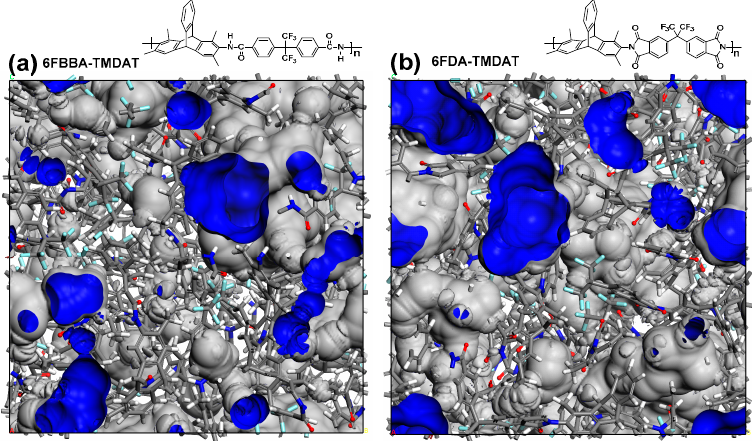
Figure 4. Amorphous-cell simulation of chain packing for: ( a ) 6FBBA-TMDAT polyamide and ( b ) 6FDA-TMDAT polyimide.